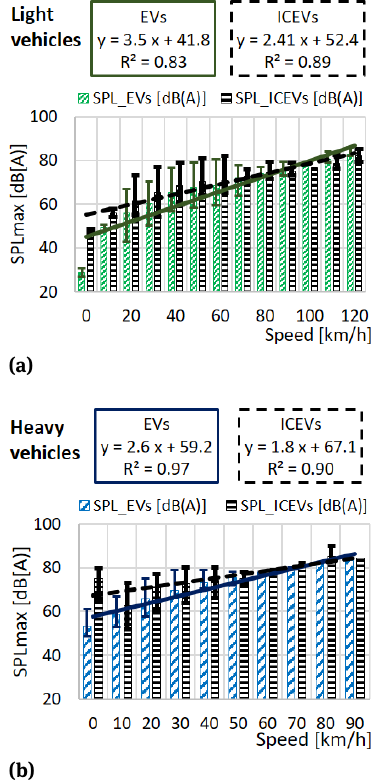
Figure 2: Relation between noise and speed for (a) light and (b) heavy vehicles (EVs, HEVs, ICEVs) based on [1, 8, 31, 32, 35, 37, 42–